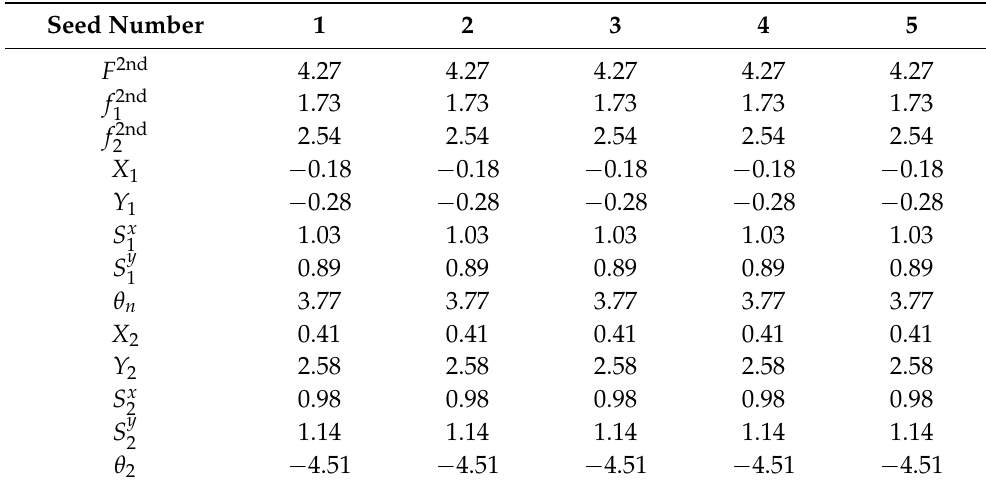
Table 11. Optimization results after second-stage optimization for the DH method.